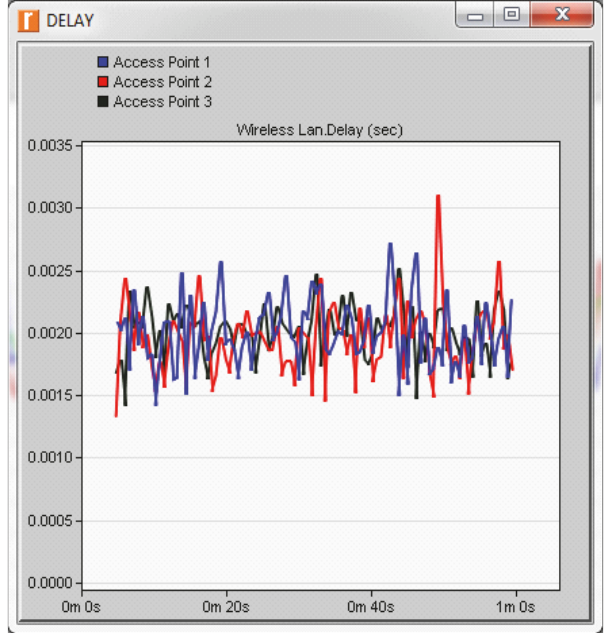
Figure 5: Wireless LAN delay of different WLAN access